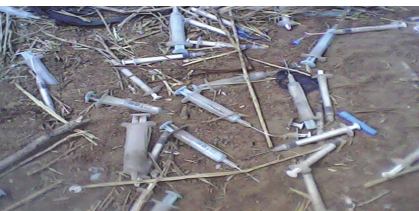
Figure 2: Syringes and needles in a municipal solid waste dumpsite at